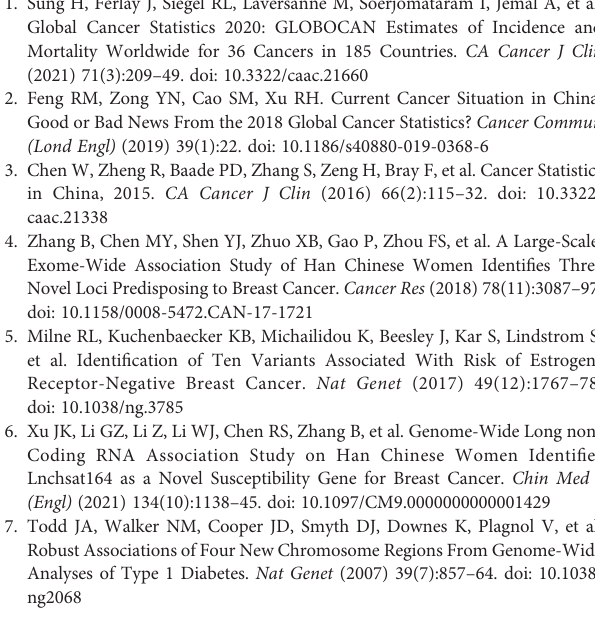
Supplementary Figure 1 | NAA25 gene expression in public databases. (A, B) Compared to normal tissues NAA25 gene was highly expressed in breast cancer tissues in Finak breast and Richardson breast databases. (C) RT-qPCR and western blot analysis in the NAA25-de fi cient MCF7 cell line. The two bands are all NAA25 . p < 0.05; ** p < 0.001. Supplementary Figure 2 | RNA-seq analysis in the NAA25-de fi cient T47D cells. (A) Pearson ’ s correlation analysis (PCA) clari fi ed the similarity between RNA-seq samples. (B) Volcano plot showing the DEG in the Ctr group and the sh2 group. (C) GO term analysis between the Ctr group and the sh1 group. (D) GO analysis between the Ctr group andthe sh1group. (E) Geneset enrichment analysis (GSEA) to analyze the DEG between the Ctr group and the sh2